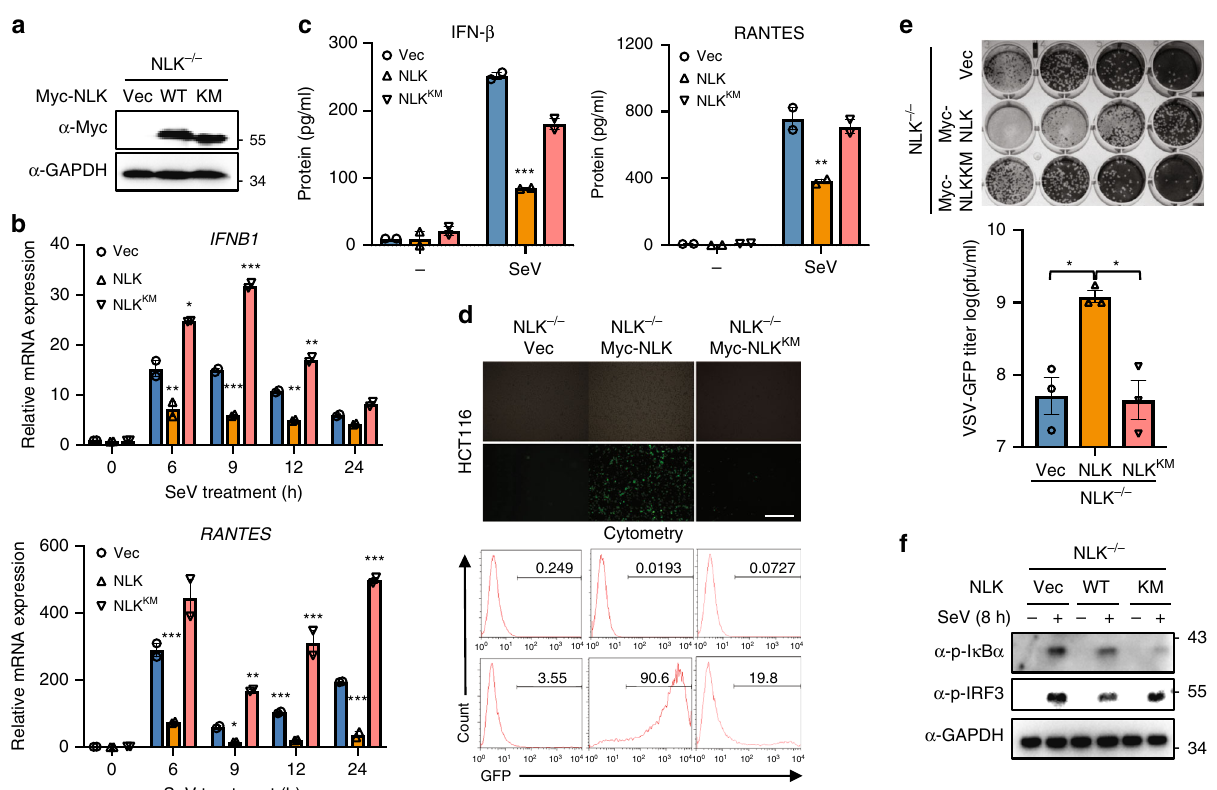
Fig. 4 NLK, but not NLK KM , reconstitution inhibits the cellular antiviral response. a The stable expression of wild-type recombinant NLK and NLK KM in NLK − / − HCT116 was veri fi ed. GAPDH was used as a loading control. b Effects of introducing the NLK or NLK KM expression plasmid into NLK − / − cells on SeV-induced endogenous IFNB1 and RANTES gene transcription in HCT116 cells. NLK − / − cells and NLK − / − cells expressing the NLK or NLK KM expression plasmids were infected with SeV at the indicated times before performing real-time PCR experiments ( n = 2). c Effects of introducing the NLK or NLK KM expression plasmid into NLK − / − cells on SeV-induced IFN- β and RANTES protein levels. NLK − / − cells and NLK − / − cells expressing the NLK or NLK KM expression plasmids were infected with SeV or left untreated for 18 h. The cell medium was subjected to ELISA ( n = 2). d Effects of introducing the NLK or NLK KM expression plasmids into NLK − / − cells on VSV-GFP infection. NLK − / − and NLK − / − cells expressing the NLK or NLK KM plasmids were infected with VSV-GFP at an MOI of 1 for 12 h before phase-contrast and fl uorescence microscopy and fl ow cytometry analysis. Scale bar is 500 µ m. e Effects of introducing the NLK or NLK KM expression plasmid into NLK − / − cells on the antiviral response. NLK − / − and NLK − / − cells expressing the NLK or NLK KM plasmid were infected with VSV-GFP at an MOI of 1, and the culture supernatants were added to Vero cells. After fi xation, cells not killed by the virus were stained with crystal violet, and the viral titer was determined ( n = 3). f Effects of NLK or NLK KM on the SeV-induced phosphorylation of I κ B α and IRF3. NLK − / − cells and NLK − / − cells expressing the NLK or NLK KM expression plasmid were infected with SeV or left untreated for 8 h. Immunoblotting was performed using the indicated antibodies. GAPDH was used as a loading control. NLK KM : Serine 167 to Alanine. Data are representative of three independent experiments. Data are presented as the mean ± SEM. Statistical signi fi cance was analyzed by ANOVA (* p < 0.05, ** p < 0.01, *** p < 0.001). Source data ( a – c , e – f ) are provided as a Source Data